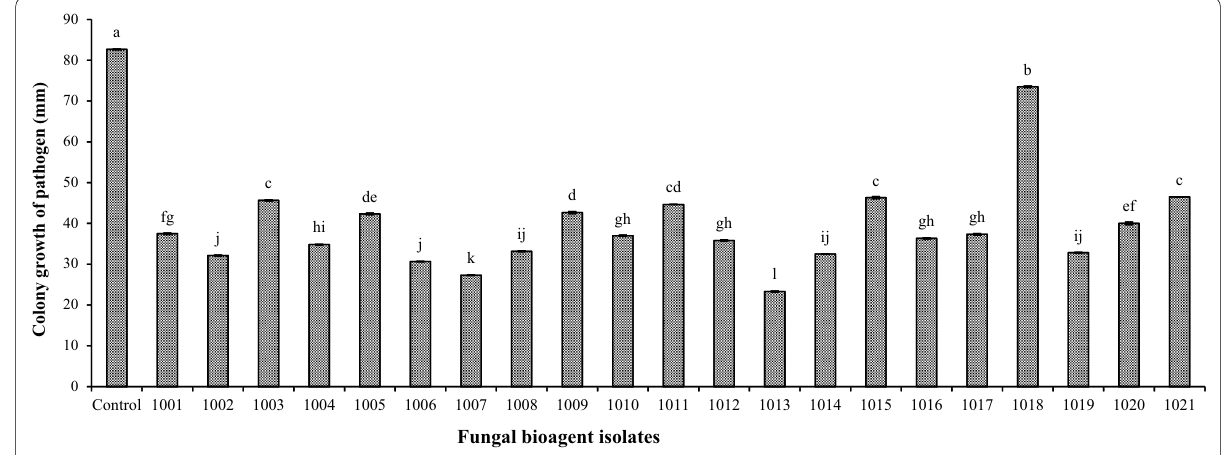
Fig. 2 In vitro screening of bio‑agents against highly virulent isolate of Alternaria solani . Values followed by different letters indicate that means are significantly different from each according to fisher’s least significant difference at p